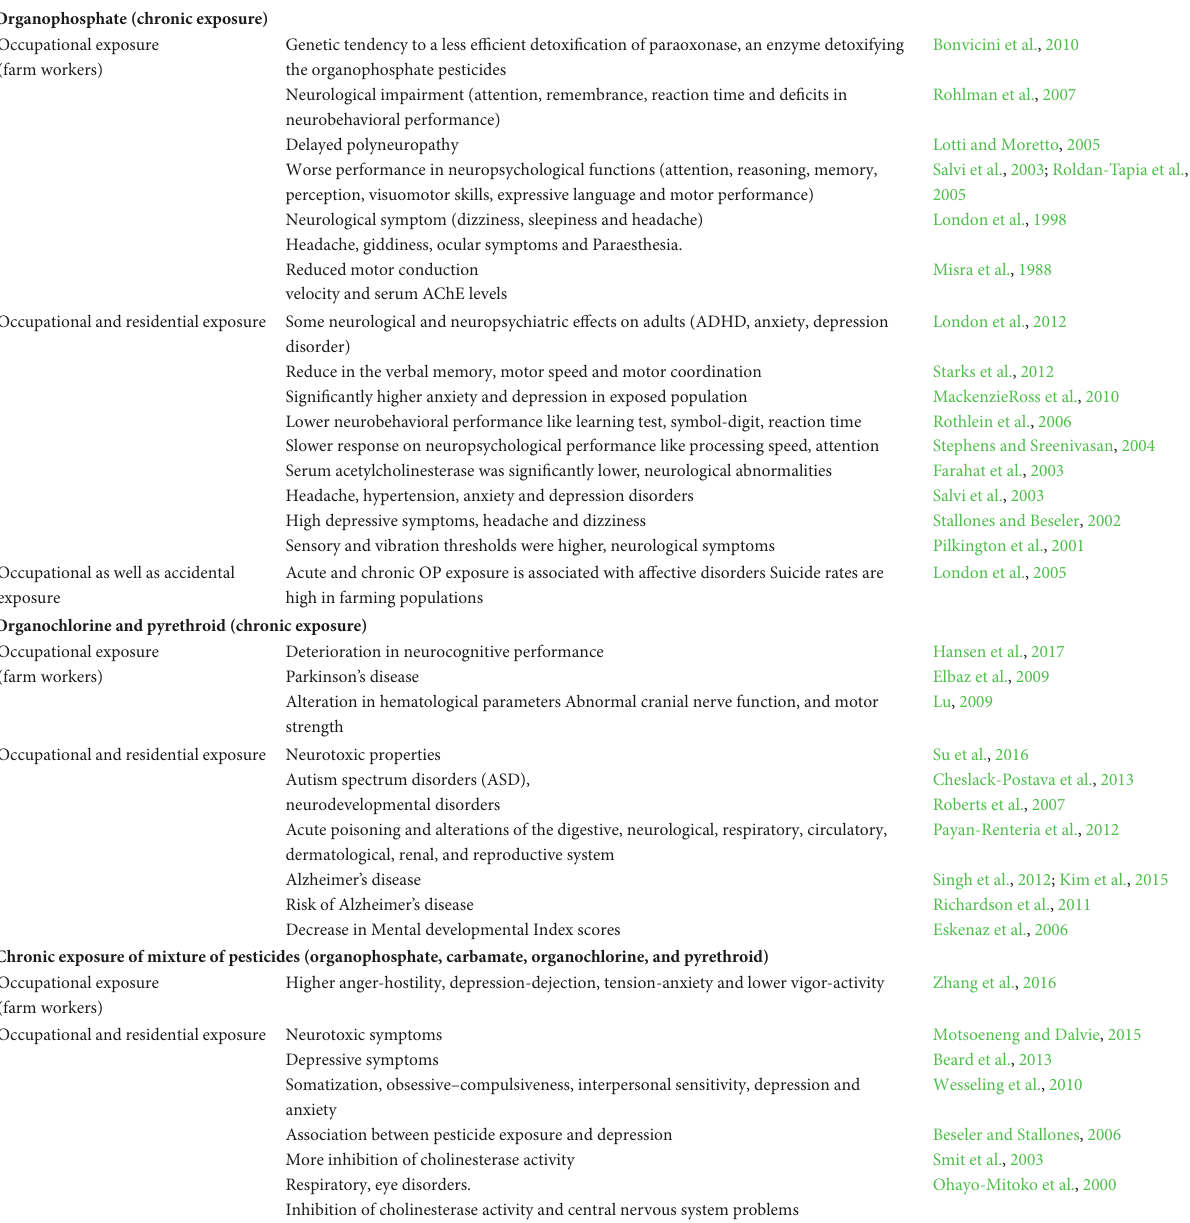
Organophosphate (chronic